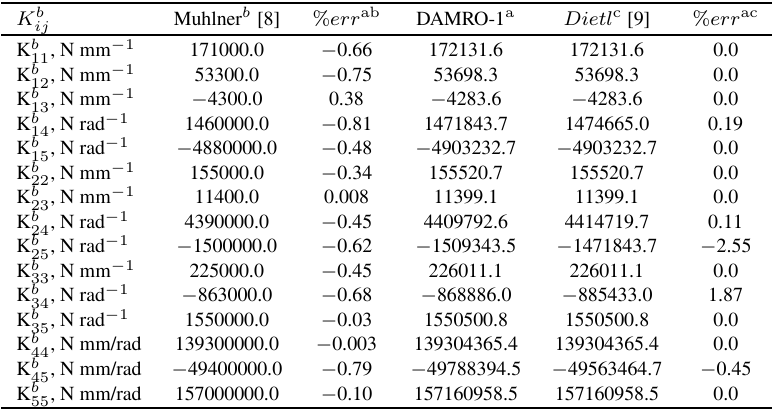
Table 2 , computed by different models. External load ij